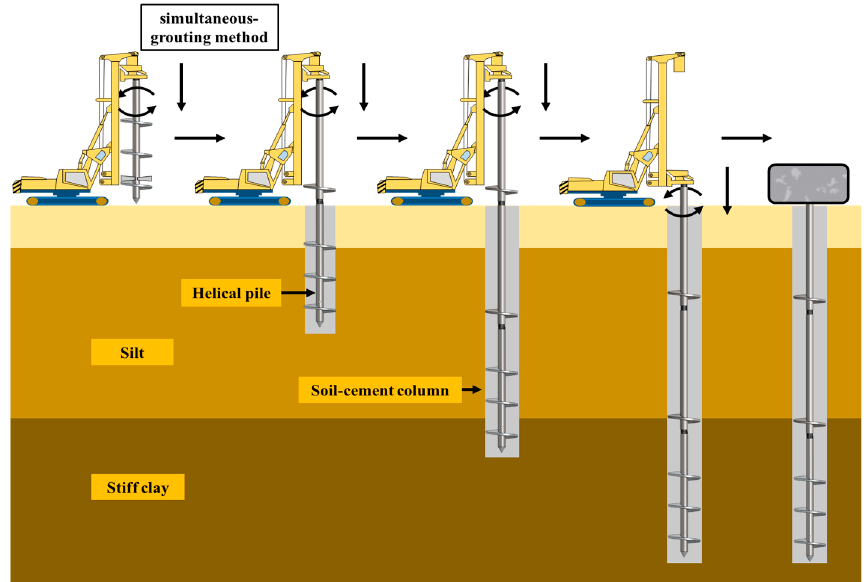
Figure 1. The installation process of HSCM-FT.